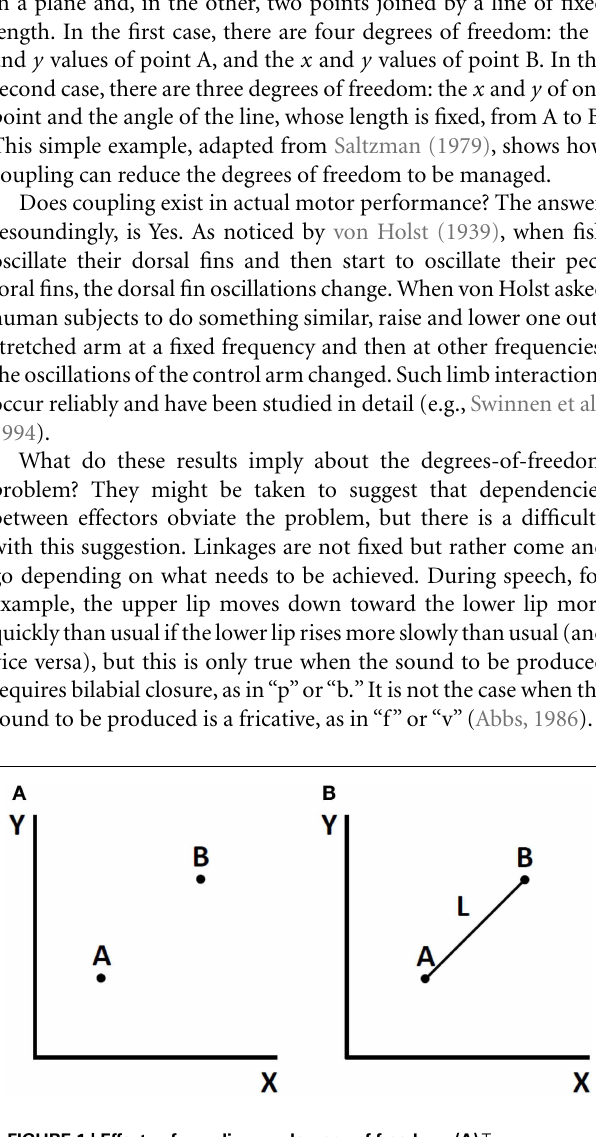
FIGURE 1 | Effects of coupling on degrees of freedom . (A) Two independent points (four degrees of freedom). (B) Two points joined by a line of immutable length (three degrees of